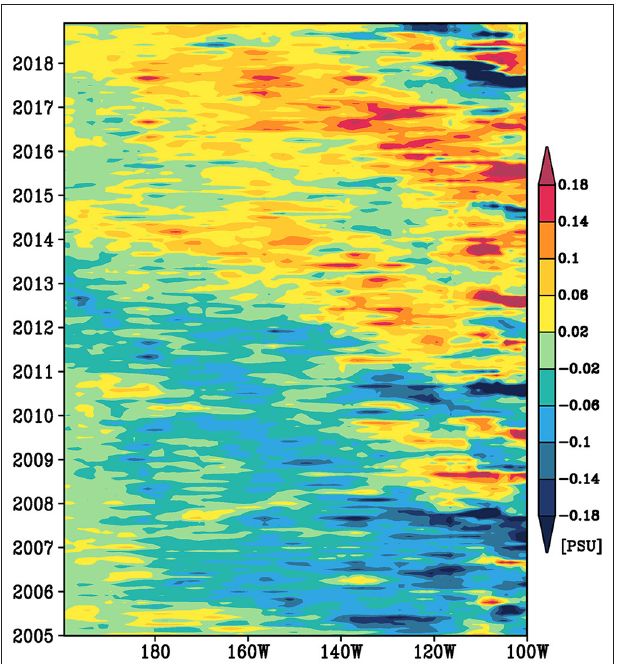
FIGURE 8 | A time-longitude diagram of the low-pass filtered salinity anomaly averaged vertically over the 25–25.5 σ θ isopycnals and meridionally over the 8,000 and 8,500kg m − 1 s − 2 mean Montgomery potential